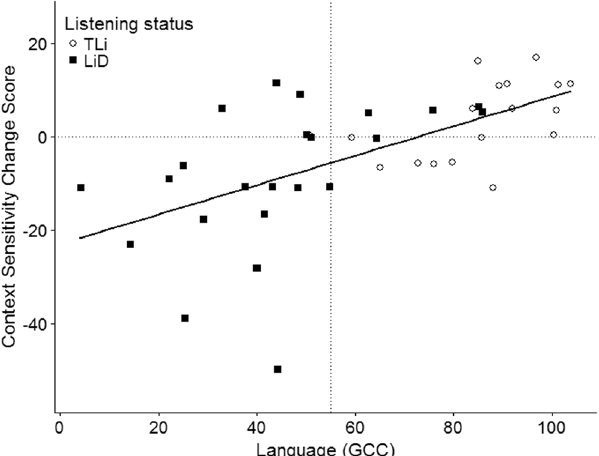
Figure 3. Correlation between the Context Sensitivity Change scores, and Language (GCC). GCC < 55 indicates significant language difficulty (vertical dotted line). Context Sensitivity Change scores < 0 indicate increasingly poor target detection over time.